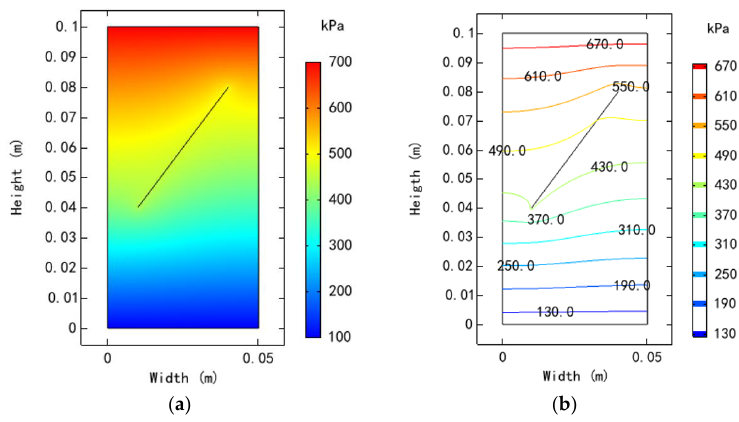
Figure 15. Distribution of gas pressure in the middle fracture model. ( a ) Gas pressure nephogram; ( b ) gas pressure isoline.